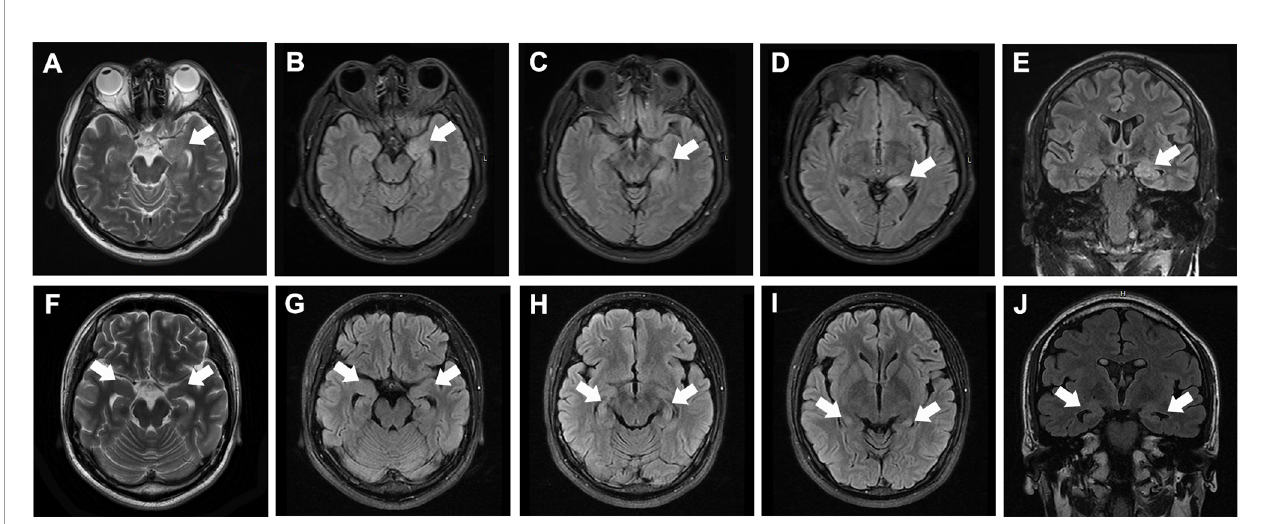
FIGURE 1 | Typical MRI of anti-LGI1 encephalitis patients. (A – E) MRI of a patient at 1 month after disease-onset, showing high T2 (A) and T2/FLAIR [ (B – D axial, (E) coronal] signals in the left hippocampus (white arrows). (F – J) MRI of a patient at 6 months after disease-onset, showing moderately elevated T2 (A) and T2/ FLAIR [ (B – D) axial, (E) coronal] signals in both hippocampi (white arrows) as well as bilateral hippocampal atrophy.